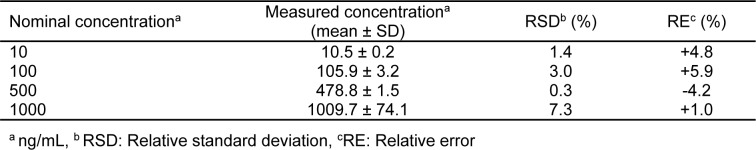
Accuracy and precision data of the proposed EME-HPLC-UV method (n = 3)